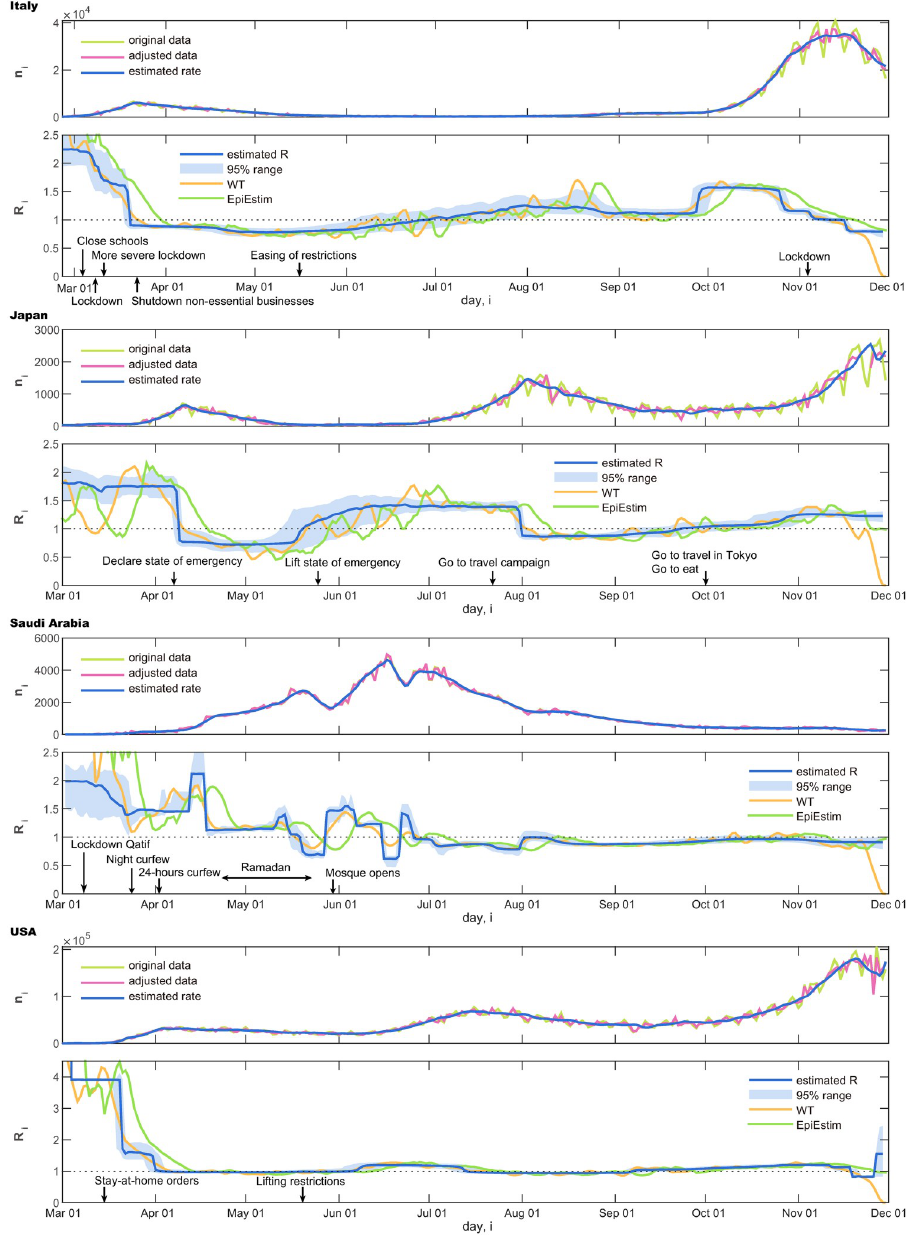
Fig 5. Number of daily new cases and the reproduction number ^ R estimated using the state-space method. Italy, i Japan, Saudi Arabia, and the USA. method for 10 days until the day before the confinement measures of each country. The initial variation in the numbers of daily new cases is depicted in Fig 7B, indicating that the estimated reproduction number is correlated to the slope in the log plot. Here we have selected the period shifted by 5 days, by taking account of the typical transmission delays. We can observe that countries in different regions tend to cluster, indicating that the susceptibility tended to be similar between nations in the same region.